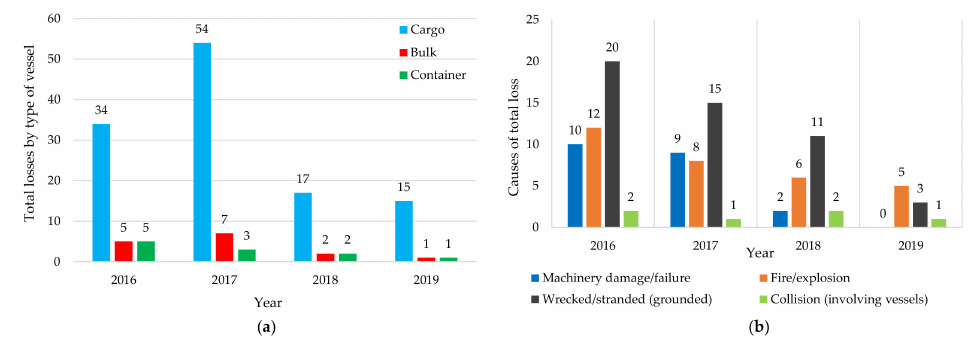
Figure 12. Total ship loss in 2016–2019. ( a ) Total loss by type of vessel and ( b ) all causes of loss (redrawn based on data in Allianz [85]).